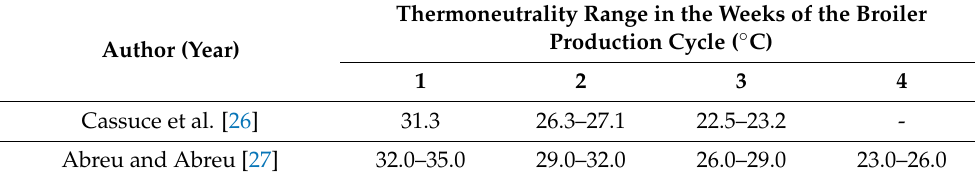
Table 1. Thermoneutrality range for